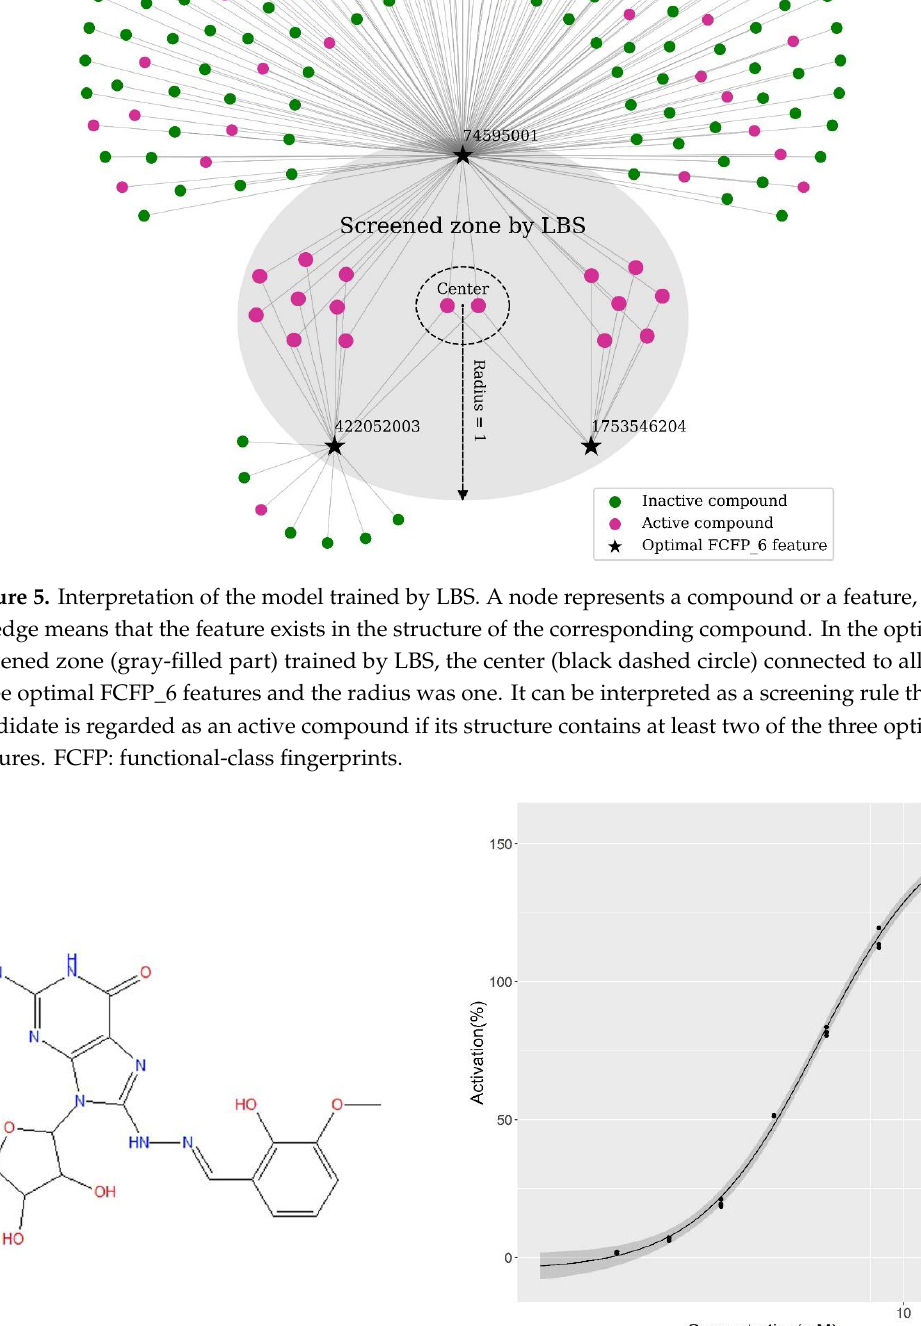
Figure 7. Binding mode of MCULE-2245265974 to HIV-1 integrase. The structure of two HIV-1 integrase monomers is shown in cartoon with chain A colored light cyan and chain B colored light yellow. Color coding of MCULE-2245265974: green carbon, red oxygen, blue nitrogen, gray hydrogen. 3. Discussion Identification of important or most informative samples in classification has been extensively studied by emphasizing samples of high variance [29] or relating the weights to loss function [30,31].